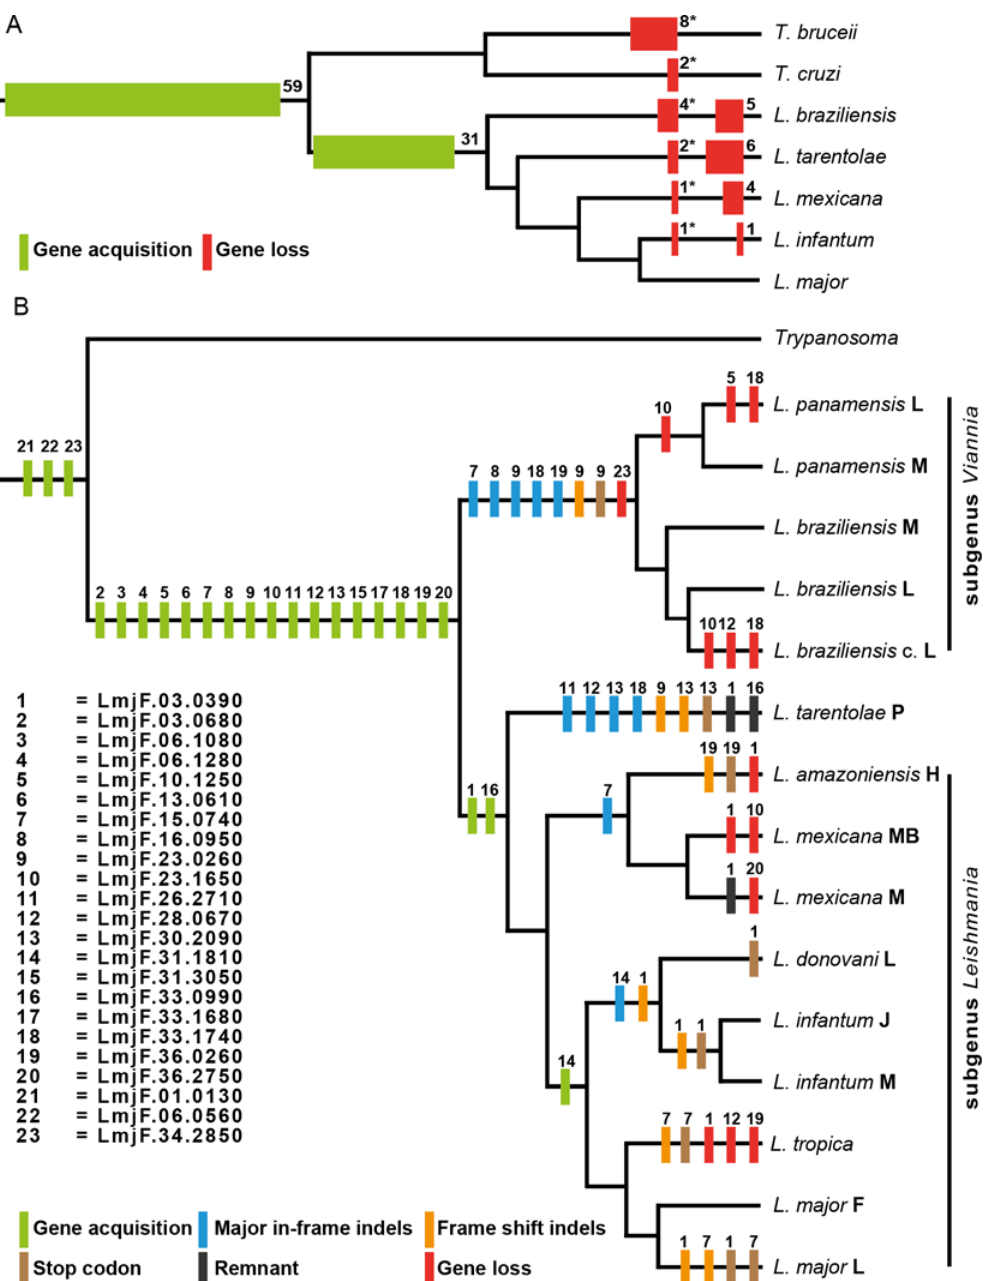
Fig 1. Consensus trees with orthologues to LGTs. (A) Phylogenetic tree (congruent with the systematics proposed by Fraga and co-workers from 2010) showing the presence of LGT orthologs in five sequenced genomes of Leishmania and the sequenced genomes of Trypanosoma cruzi and Trypanosoma bruceii . The number of acquired genes (green boxes) and lost genes (red boxes) are presented numerically. (Red boxes * ) refers to gene loss of orthologs to universal trypanosomatid LGTs. (B) Consensus tree summarizing the agreement between the phylogenetic trees for the twenty-three LGTs, investigated in detail in this study. Genus Leishmania is divided into the three subgenera Viannia , Sauroleishamania (here represented by only one species and one strain – L . tarentolae ) and Leishmania . Subgenera Viannia and Leishmania are further divided into several complexes, and the topology of the consensus tree is completely congruent with the systematics proposed by Fraga and co-workers (2010). The fate of each LGT is illustrated with coloured boxes. “ Gene acquisition ” (green boxes) and “ Gene loss ” (red boxes) are based on presence of orthologs in published genomes or amplification of orthologs with PCR. Insertions/deletions (indels) (blue and orange boxes) and presence of stop codons (brown boxes) have been determined by manual inspections of alignments of obtained sequences and are relative to the gene sequence in L . major F. “ In-frame Indels ” (blue boxes) are insertions or deletions of more than 50 nucleotides not causing any frame-shift. “ Frame-shift Indels ” (orange boxes) are insertions or deletions that causes frame-shifts. Remnants (black boxes) of orthologs have been identified with synteny analyses (see Material and Methods).